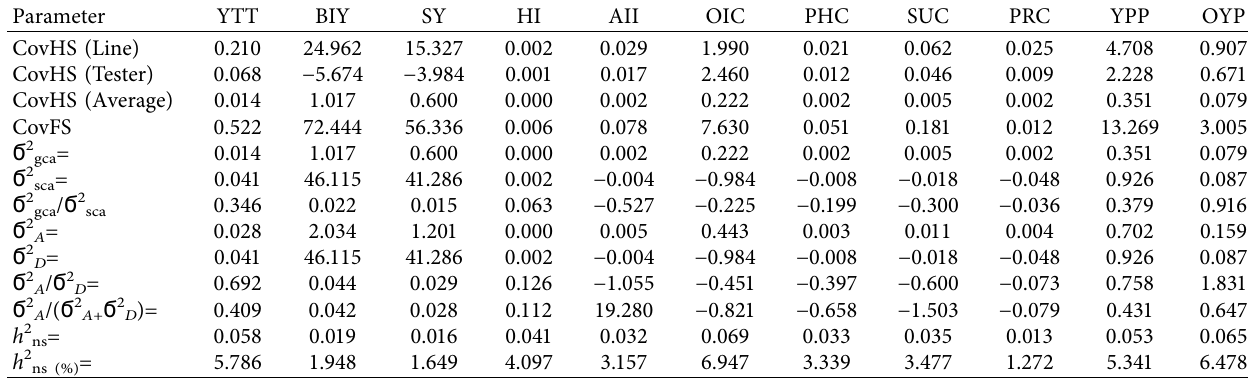
Table 14: Estimates of genetic variance for yield and its attributed traits in mustard.